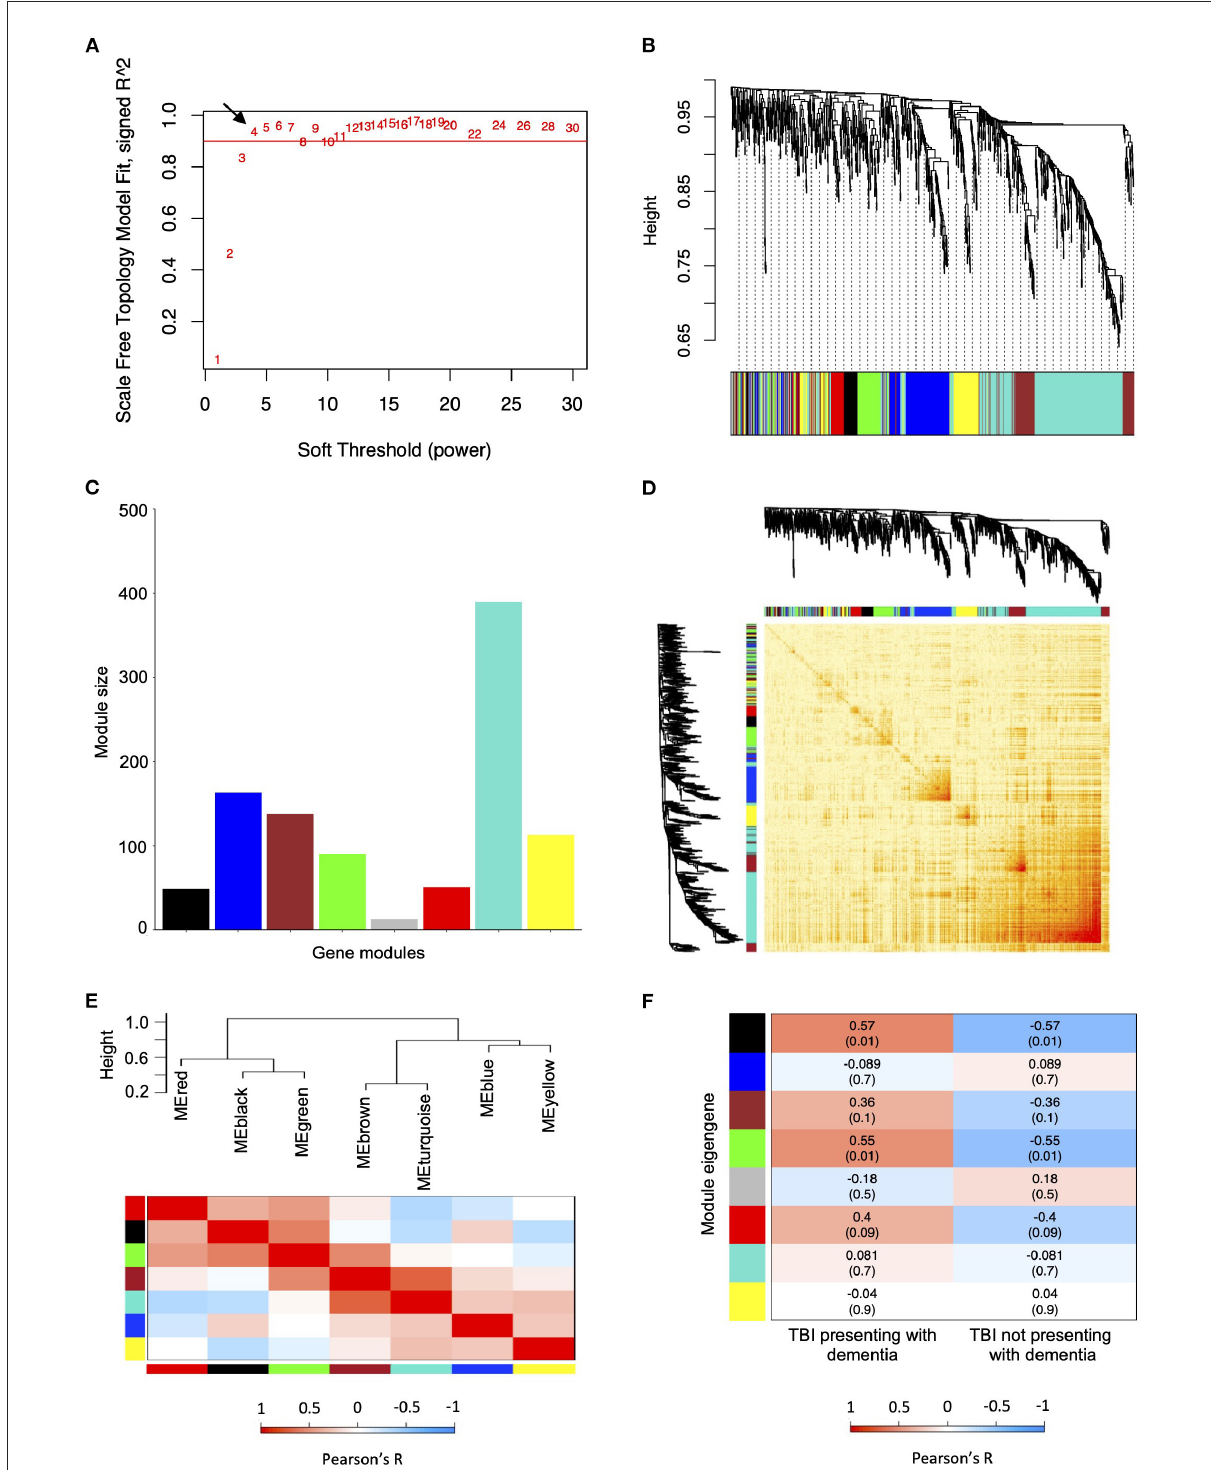
FIGURE2 Weighted co-expression network analysis for traumatic brain injury (TBI)-associated differentially expressed genes identified from the female hippocampus. (A) Scale free fitting index of different soft thresholds ( β ), showing the scale-free model fit as a function of β . Four was selected as the β for the female hippocampus analysis. (B) Co-expression cluster dendrogram of TBI-associated differentially expressed genes (DEGs). Gene modules were assigned unique colors. Each line represents a single gene, and the height on the y-axis represents dissimilarity in